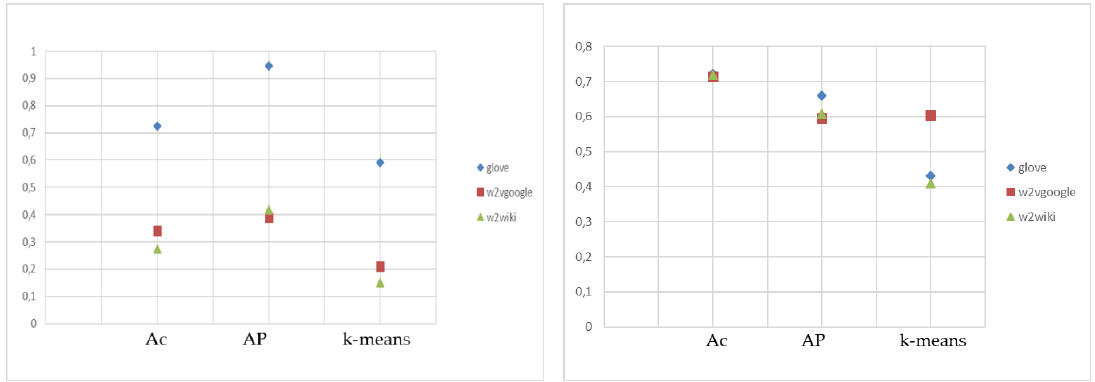
Figure 4. Comparison of similarity measures (Cosine similarity vs. Euclidean distance) on 1-g (on the left) and n-grams (on the right).